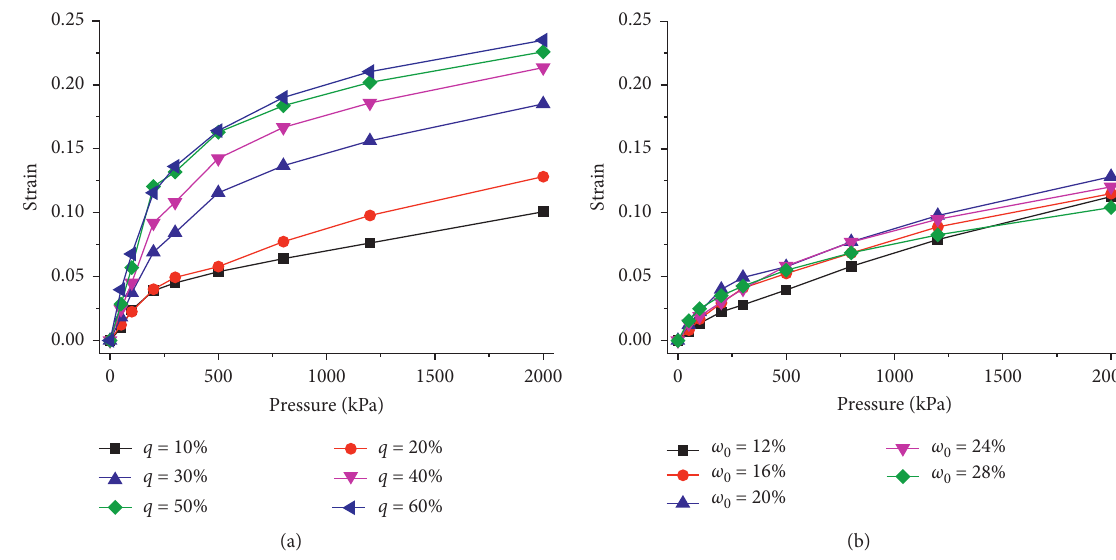
Figure 8: Variation of strain with pressure. (a) At different clay contents. (b) At different initial water